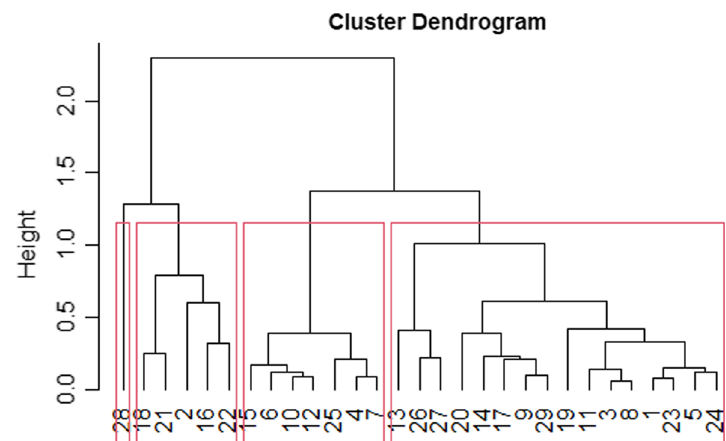
Fig. 9 Cluster dendrogram with time series correlation in stage